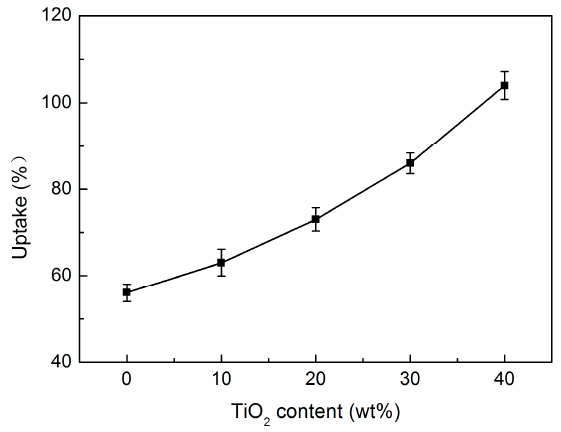
Figure 8. Electrolyte uptake of the PP/TiO 2 composite membranes as a function of TiO 2 content.